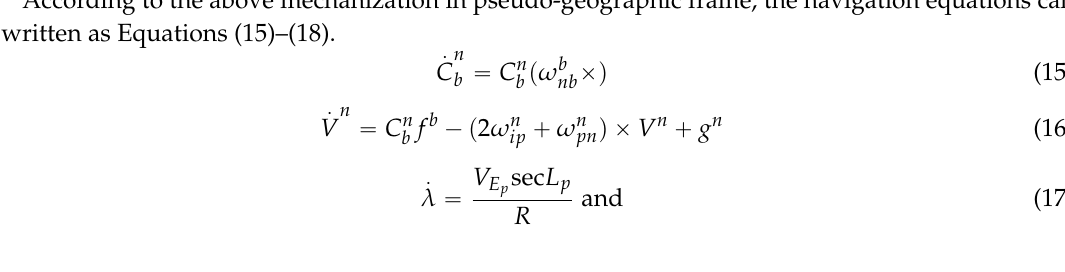
Figure 2. The strapdown inertial navigation system (SINS) mechanization in pseudo-geographic frame.